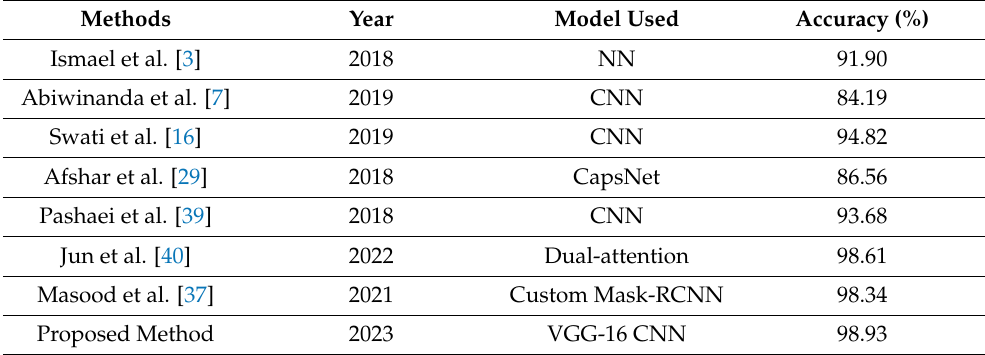
Figure 8. Learning curve of the proposed framework illustrating percentage of accuracy versus number of iterations. Table 5. Performance Comparison of Proposed Transfer Learning based DCNN Model with Existing Learning based Approaches on Figshare